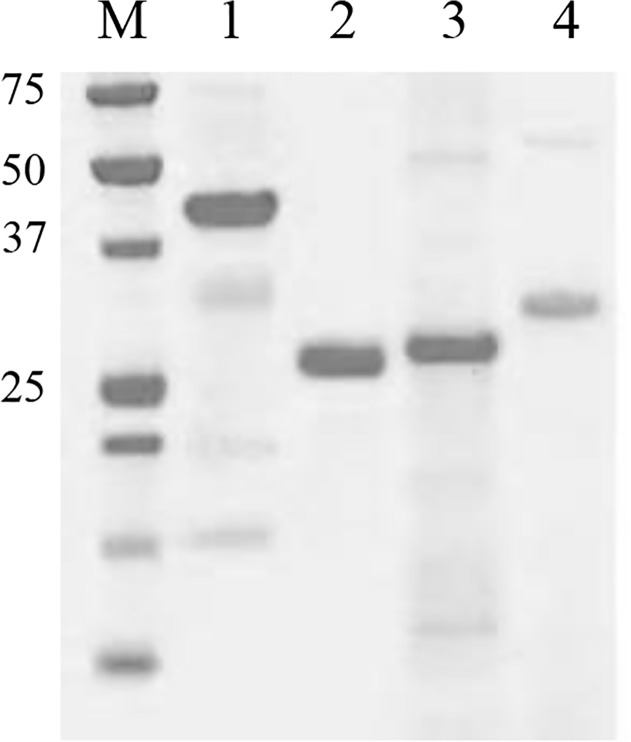
LDS-PAGE detection of the purified and dialyzed S. aureus antigens.Fifteen μg of LytM-His6 (1), Nuc-His6 (2), IsaA-His6 (3) or His6-pro-Atl (4) was loaded. The molecular weight of marker proteins is indicated (in kDa).